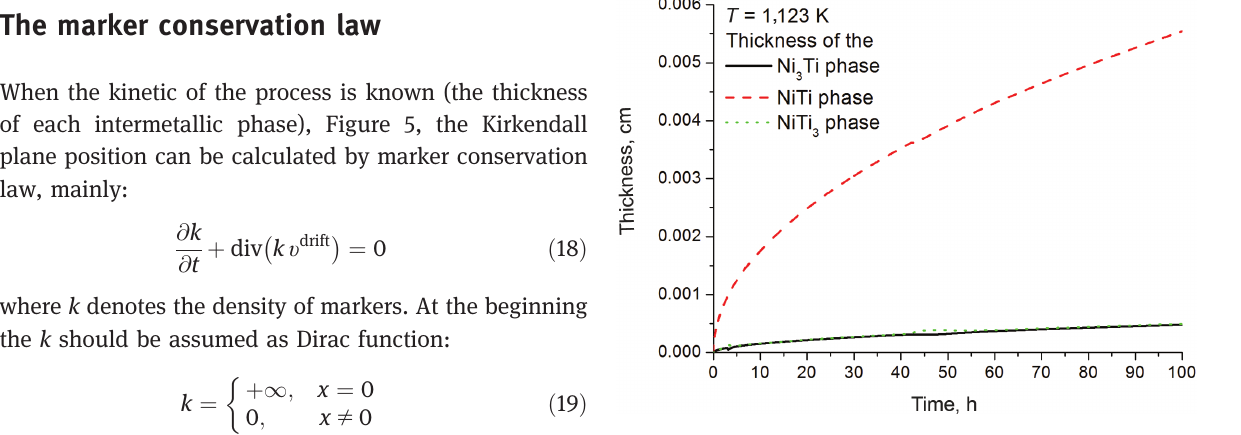
Figure 5: The kinetic of the intermetallic phase formation in Ni – Ti alloy at 1,123